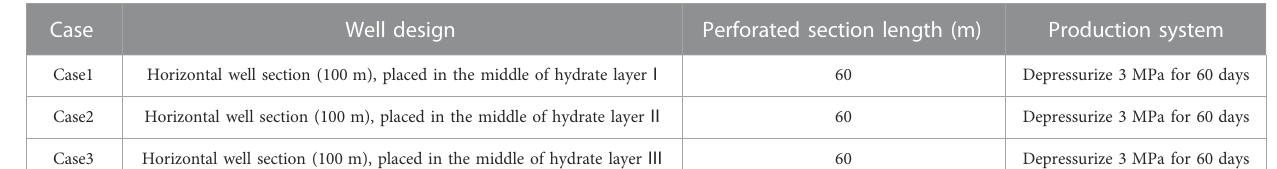
TABLE 3 Optimized the placement of horizontal well section.